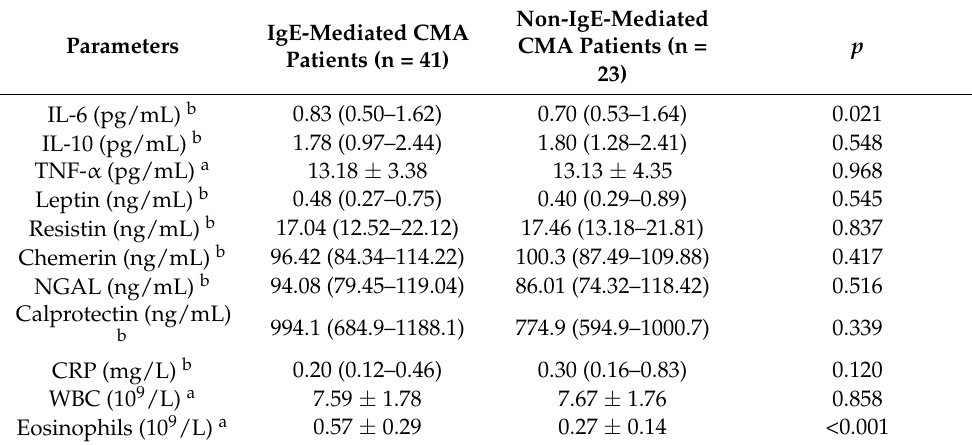
Table 3. Biochemical parameters associated with inflammation in groups of children IgE-mediated CMA and non-IgE-mediated